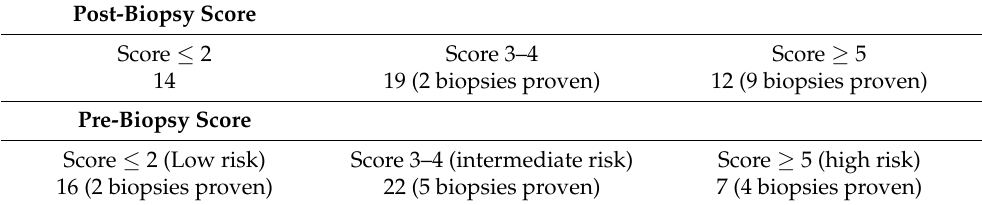
Table 5. rACR (n = 45).